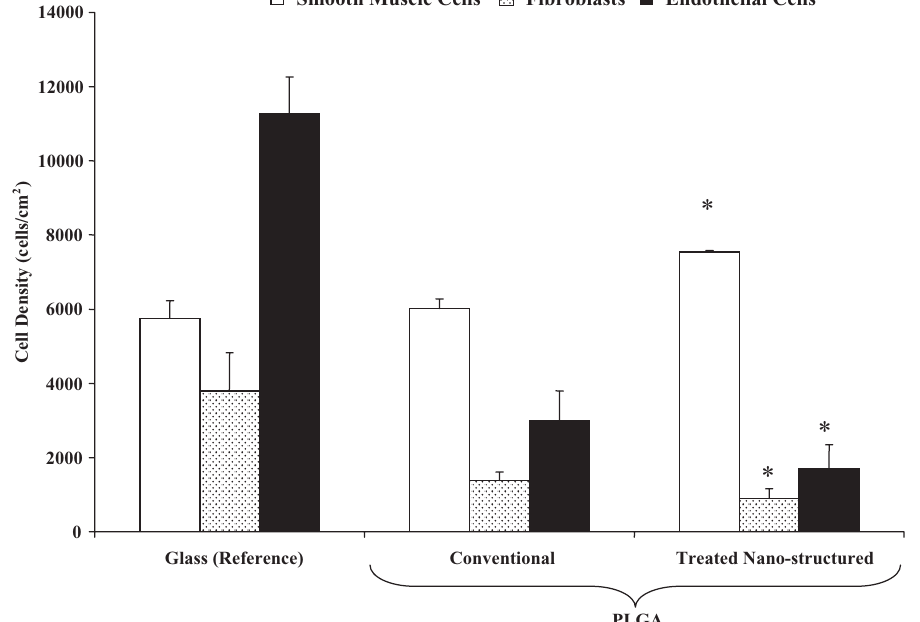
Figure 3 Endothelial cells, vascular smooth muscle cells, and fibroblasts proliferated differently on nano-structured PLGA.